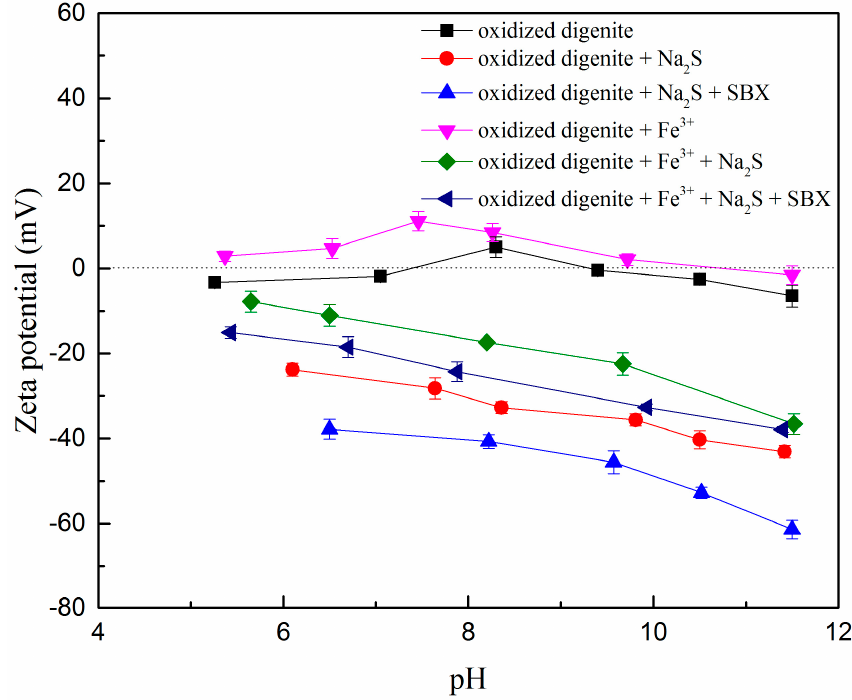
Figure 5. Zeta potentials of oxidized digenite as a function of pH with different treatments (Fe 3+ dosage: 1 × 10 − 3 mol/L; Na 2 S dosage: 1.25 × 10 − 3 mol/L; SBX dosage: 1 × 10 − 4 mol/L).